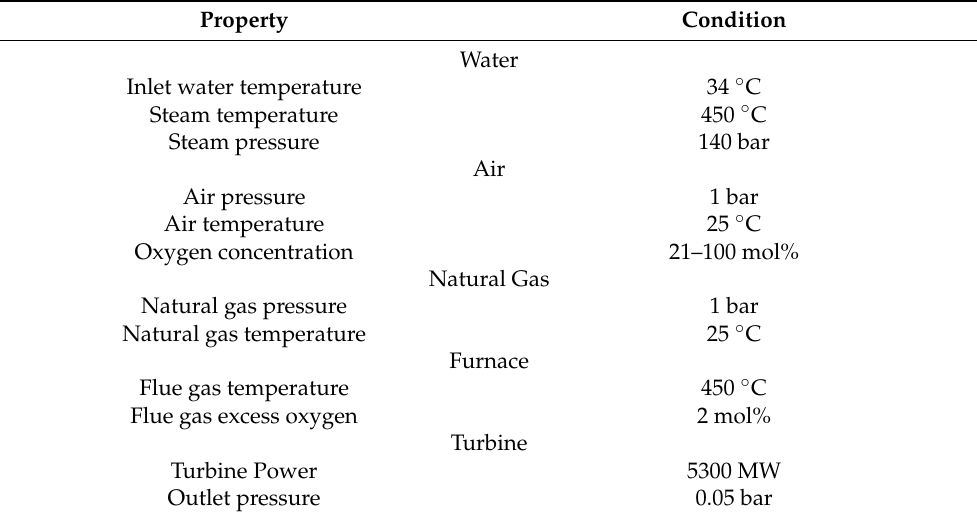
Table 3. Operating conditions for the simulation of the Alzour power plant.